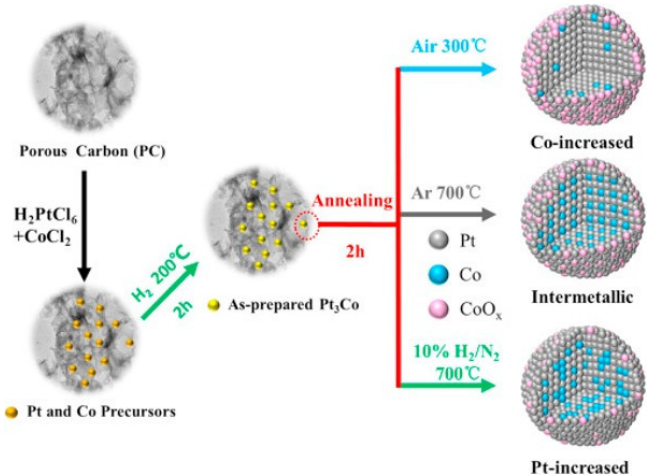
Figure 7. Schematic illustration of fabricating Pt 3 Co/PC catalysts and tuning their surface composition via adsorbate-driven segregation at different annealing atmospheres. Reprinted with permission from reference [77]. Copyright 2017 Elsevier.